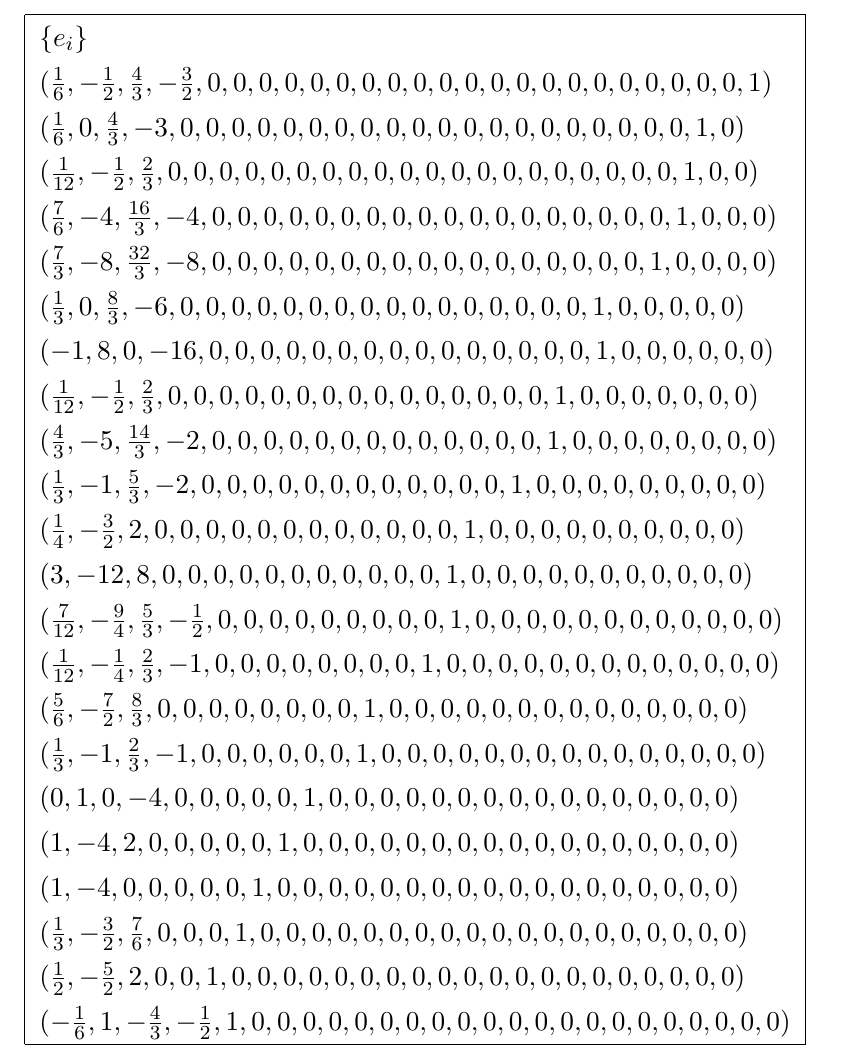
Table 3. Coefficients of quartic ETQT gravity for D = 3